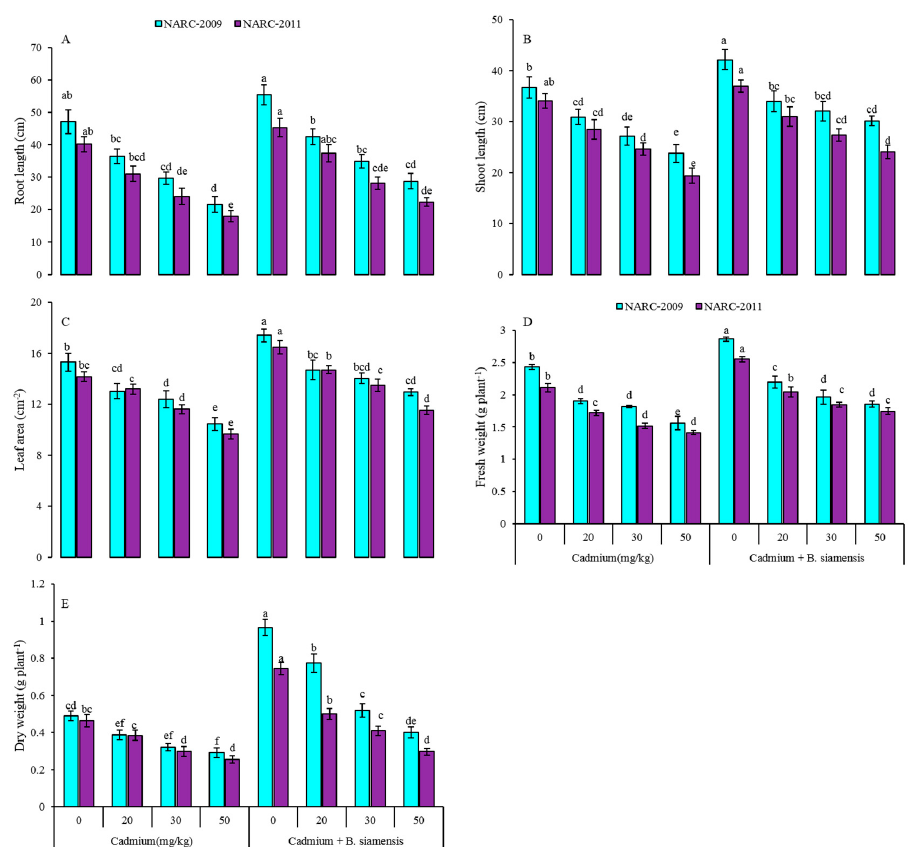
Figure 1. Effect of seed inoculation with Bacillus siamensis on root length ( A ), shoot length ( B ), leaf area ( C ), fresh weight ( D ), and dry weight ( E ) of two wheat varieties under Cd stress. Data are expressed as the means of three replicates. Bars show ± SD and different letters show a significant difference among treatments at 0.05 level.